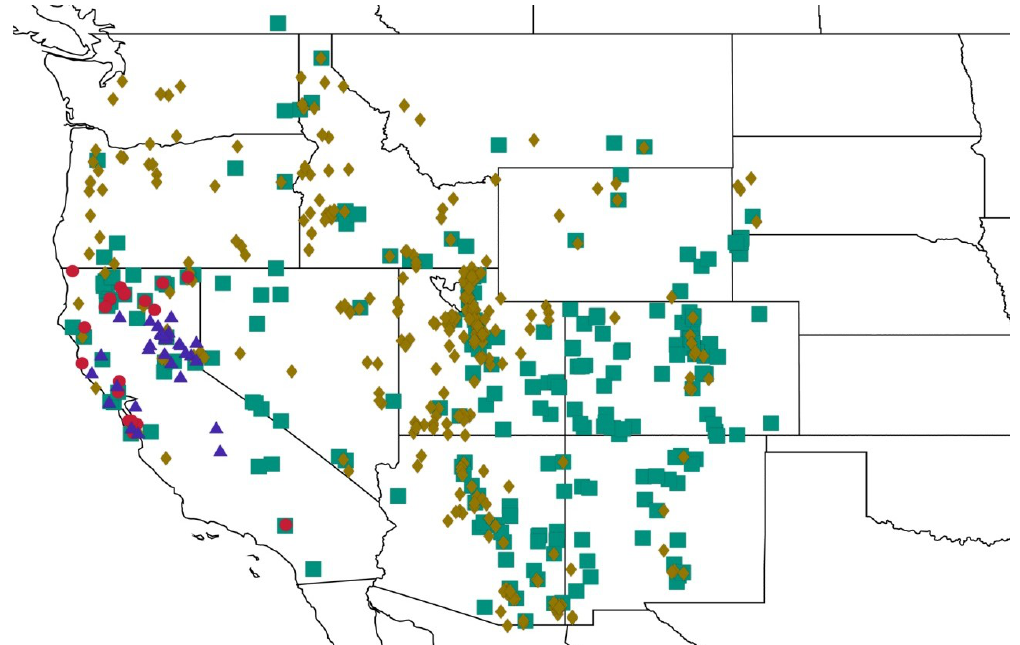
Figure 35. Distribution of Platypedia putnami putnami (green squares), P. putnami lutea (gold diamonds), P. putnami occidentalis (red circles) and P. putnami keddiensis (purple